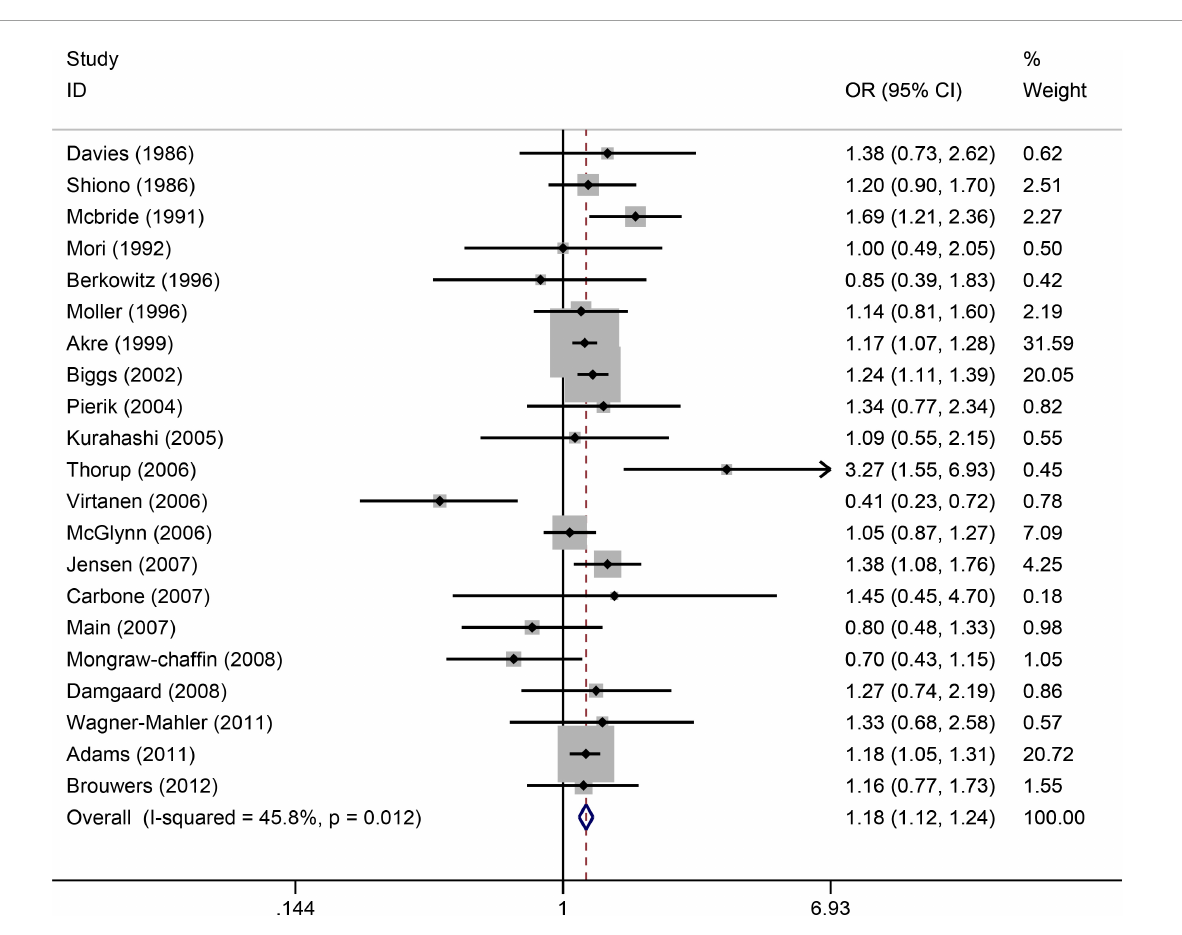
(I 2 = 45.8%, p = 0.012), a fixed effects model was used. Based on Egger’s test ( p = 0.689), there was free publication